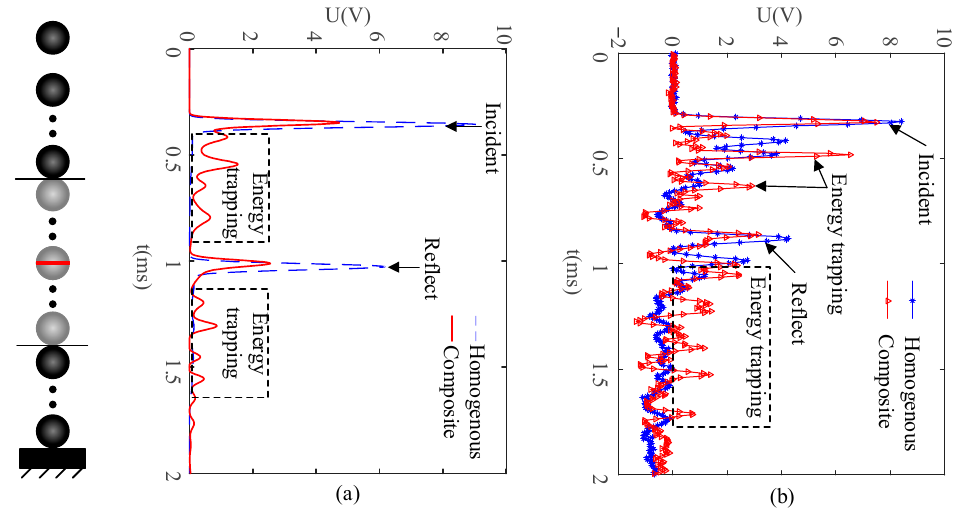
Figure 2. ( a ) Predicted and ( b ) measured output voltage signals of PEH. From the Simulink module, the parameters of the electronic components are listed in Table 1. When the switch K was in the off state, the open circuit voltage waveform after rectification was as shown in Figure 3a. When the switch K was closed, the voltage of the energy storage capacitor could be measured. A total of 1000 impacts were investigated for predicting the rising trend in the voltage of the energy storage capacitor. Figure 3b demonstrates the voltage of the energy storage capacitor in the entire charging process.